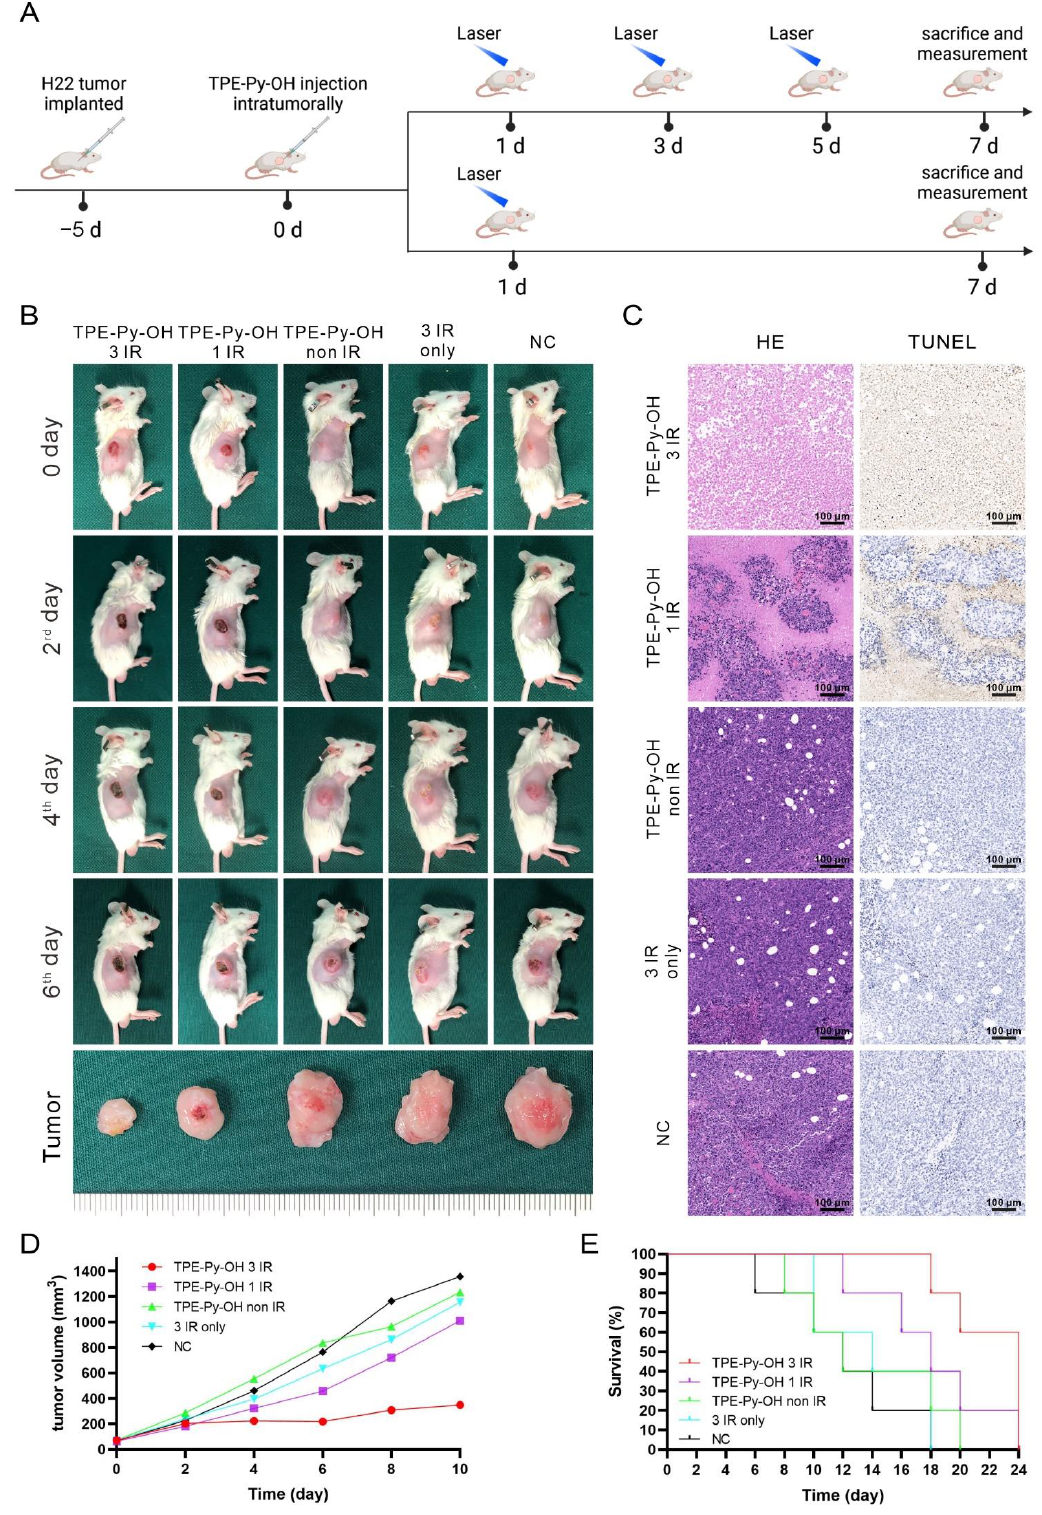
Figure 5. In vivo multiple light-activated PDT effect of TPE-Py-OH in H22 tumor-bearded mice. ( A ) Scheme of in vivo PDT experiment. ( B ) Representative photographs of mice with treatments at different days, the irradiation was performed with 450 nm laser (100 mW/cm 2 ) for 10 min. ( C ) H&E stained and TUNEL stained tumor tissue slices after 7 days of treatments. ( D ) Tumor growth curves of mice with the various treatments. ( E ) Survival of mice with the various